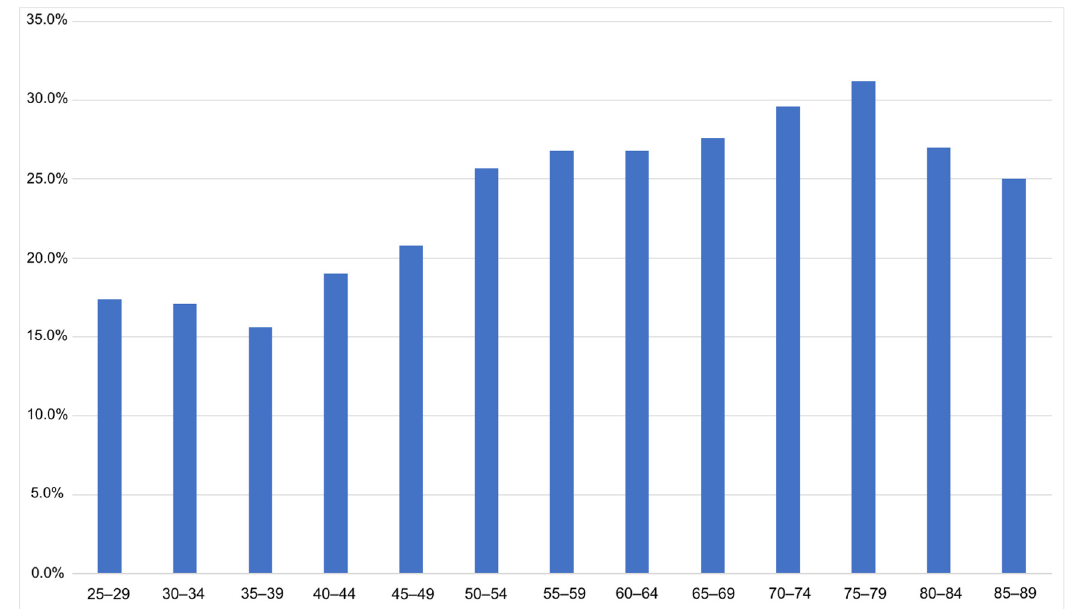
Figure 2. Prevalence of tinnitus by age group (x-axis: age groups in 5 year increments; y-axis: prevalence in %).